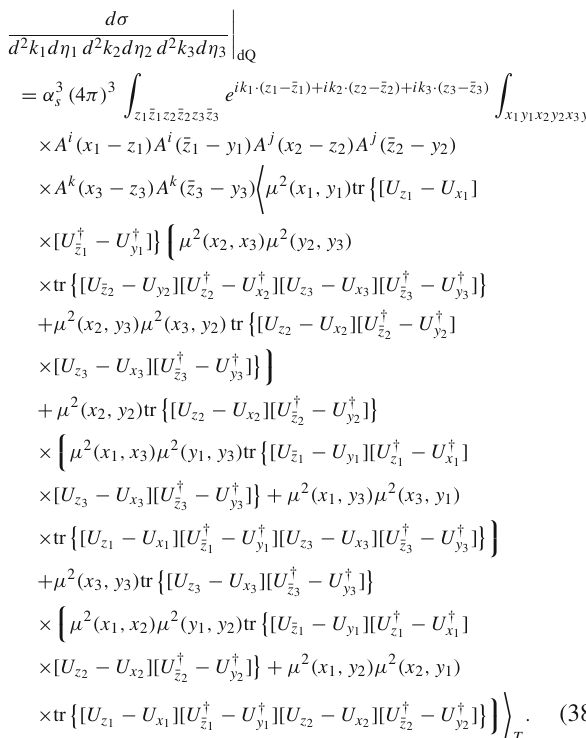
third and fourth terms in Eq. (35) fall into this category and, using these three terms, we can write the dQ-contribution as